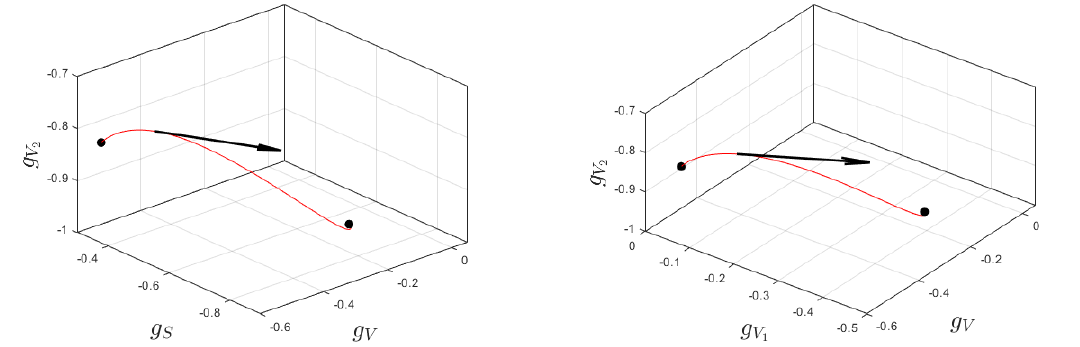
Figure 14. Fixed points and a critical heteroclinic orbit of the QCD (3 ; 11) and (cid:11) g = (cid:11) nt . Left: projection on the ( g S ; g V ; g V g ( g V ; g V ; g V 1 2